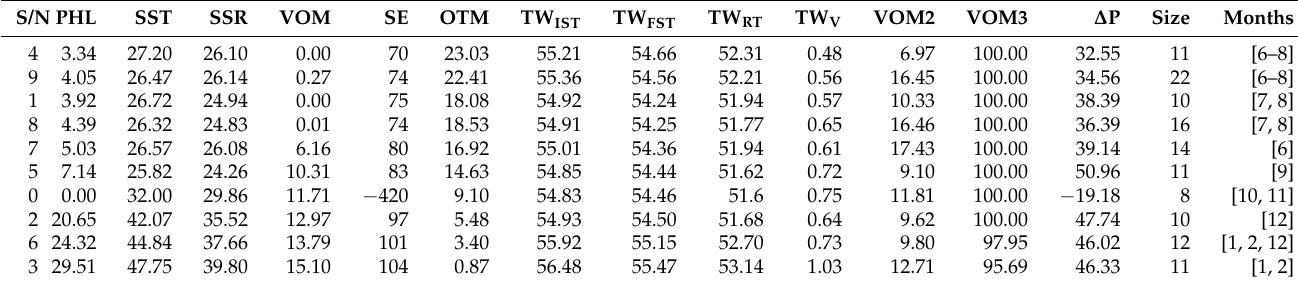
Note. The units for PHL and TW V are kw and m 3 , respectively. The unit for TW IST , TW FST , TW RT , ∆ P , and OTM is ◦ C. VOM, VOM2, and VOM3 are expressed in %. For the full form of each feature see Tables 1 and 12. Table 17. Closed patterns from global model showing correlations between all six views after receiving chunk 3. Values are sorted based on